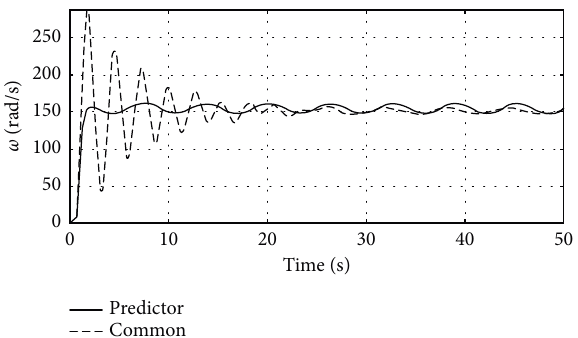
controller with a ∞